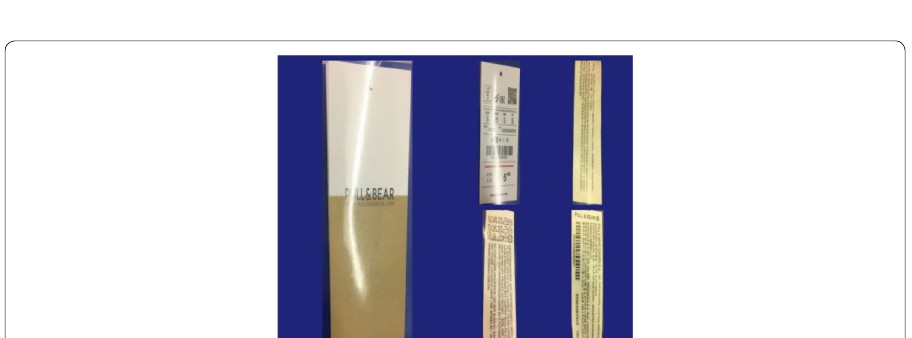
Fig. 12 Zara label